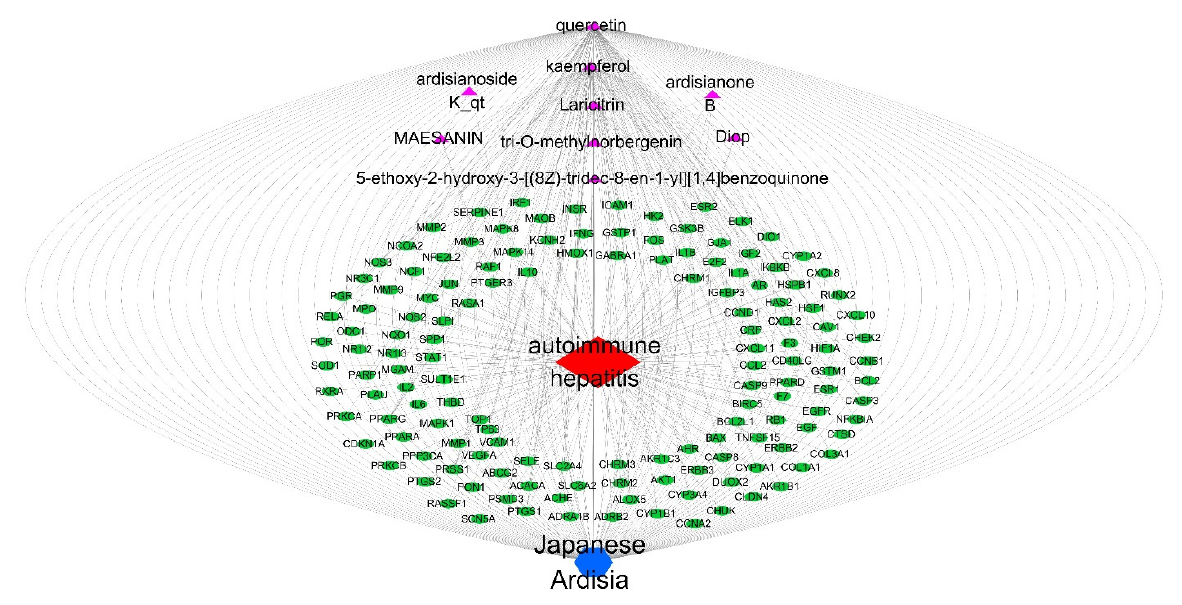
Figure 4. Network diagram of “Japanese Ardisia -component-gene-autoimmune hepatitis”. Note: Japanese Ardisia is blue; components are purple; the gene is green; and autoimmune hepatitis is red.